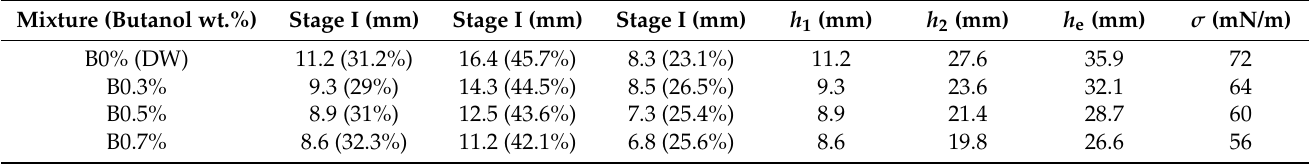
Table 2. Lengths of characteristic stages for butanol/water mixtures at the test case of r = 0.4 mm. Mixture (Butanol